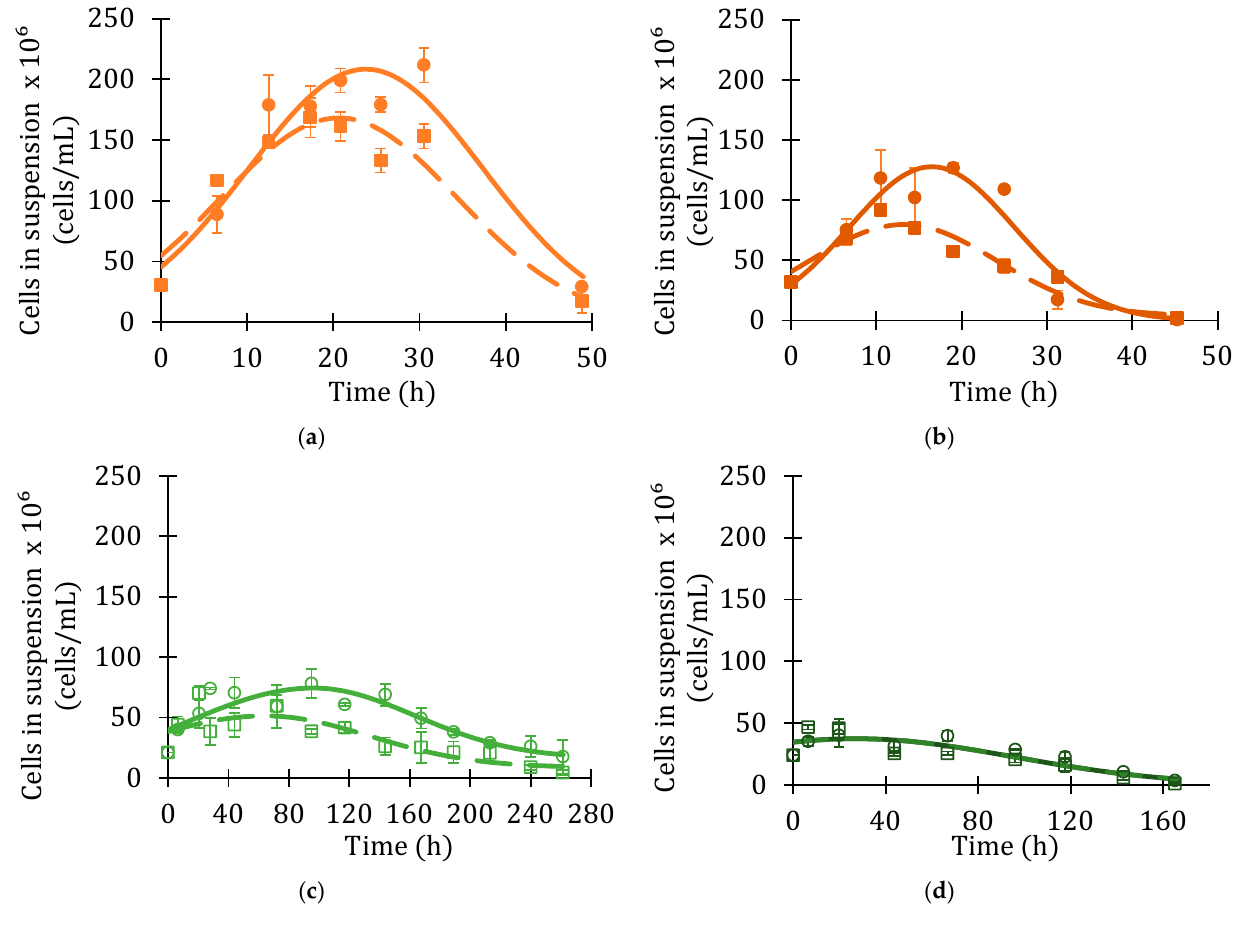
Figure 5. Viable cells in suspension throughout each fermentation configuration: ( a ) LTHF (orange); ( b ) HTHF (dark orange); ( c ) LTLF (green); ( d ) HTLF (dark green). Fermentations were performed in duplicate. Models were obtained using a step model, with a 95% confidence interval and the error bars represent the standard deviation of the data. The data shown represent cells in suspension under vacuum (circles) and atmospheric pressure (squares); high FAN (filled) and low FAN (empty); high temperature (darker shade) and low temperature (lighter shade). Cells in suspension model under vacuum (continuous lines) and atmospheric pressure (dotted lines).